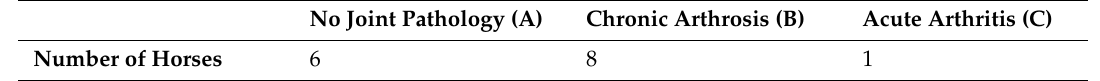
Table 6. Number of horses in groups A, B, and C.